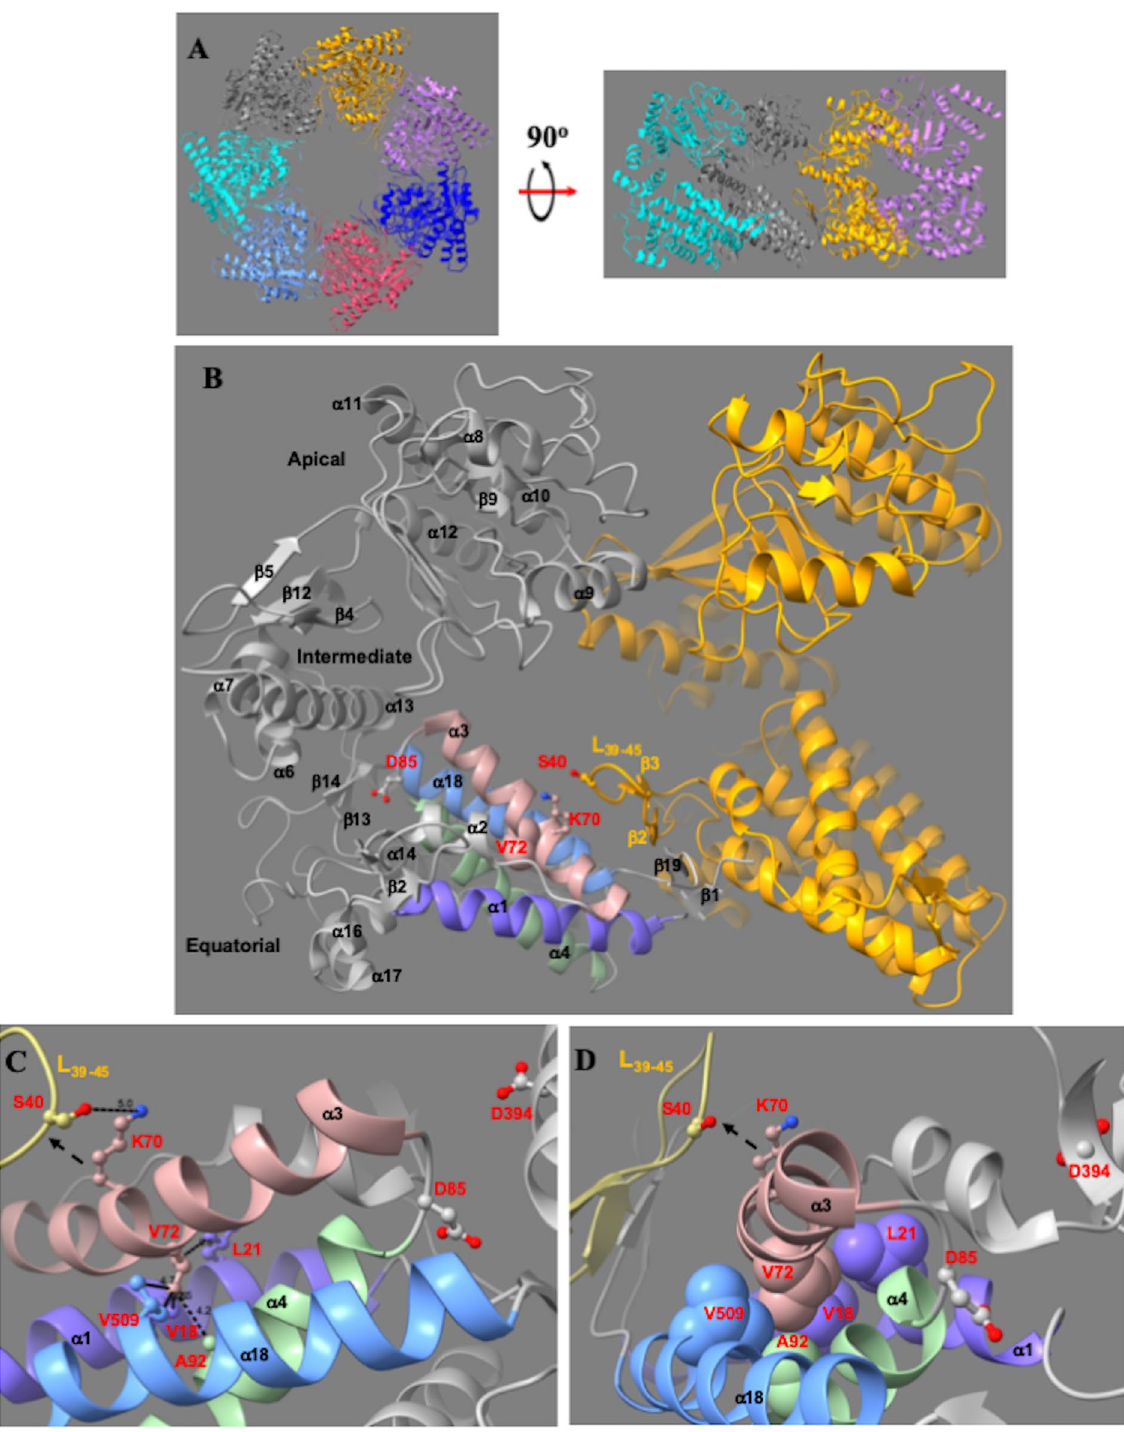
Figure 1. The proposed allosteric role of V72I mutation on the structural stability and the ATPase activity. ( A ) Overall structure of the mHsp60 heptamer. Left, view from the apical domains down to the equatorial domains; right, a sectional view of the sideview of the heptamer after removing three front subunits. Subunits in gray and gold are annotated in B). ( B )The loop prior to α3 where V72 is located contains D85, the residue important for the ATP activity. The C-terminus of α3 is close to the inter-subunit interface: K70 on α3 of one subunit (gray) is near S40 from the neighboring subunit (gold). ( C )V72 serves as the critical point where α3 (pink) transverses the α1-α4-α19, purple, green and blue, respectively, helical bundle. The V72-interacting residues are shown with sidechains, and distances between the sidechain of V72 and those of the interacting residues are shown and summarized in Table 3. Like D85, D394 is also important for the ATP activity. ( D ) Sidechain of V72 is embedded in a hydrophobic pocket in the three-helical junction. The ball-and-stick representation shows that sidechain of V72 is in direct van-der Waals contact with those of V18 and L21 (α1), A95 (α4) and V509 (α18). V72I mutation, mutation to a large residue, most likely shifts helix α3 towards the S40-containing loop of the neighboring subunit, diagramed with dashed arrows, enhancing the inter-subunit interaction and the structural